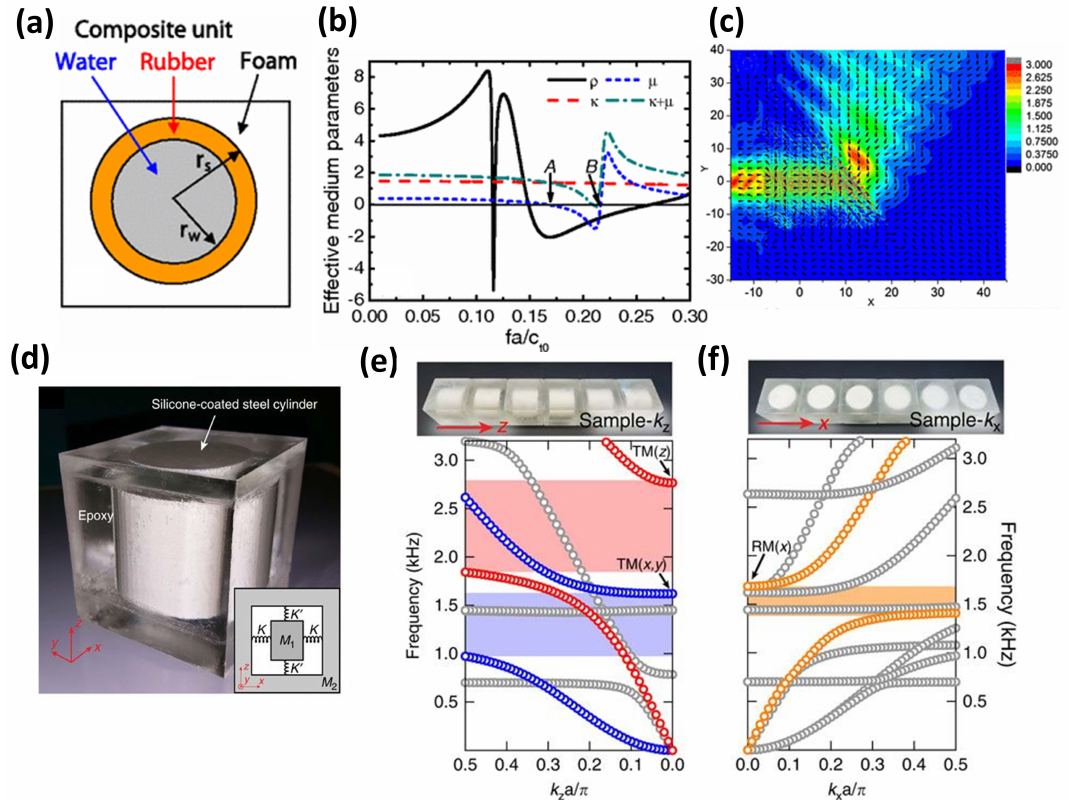
Figure 1. ( a ) Unit cell of the locally resonant elastic metamaterial (EMTM); ( b ) Effective medium parameters of proposed EMTM. Black line: mass density, ρ . Blue line: shear modulus, µ . Red line: bulk modulus, κ . Green line: κ + µ ; ( c ) Total flux distribution for a transverse wave incidence on the wedge. Colors: the magnitude. Black Arrows: directions; ( d ) Unit cell design of a locally resonant EMTM; ( e ) The band structure of z-axis alligned EMTM. Blue shaded region: a flexural bandgap. Red shaded region: a longitudinal bandgap; ( f ) The band structure of x-axis alliged EMTM. Orange shaded region: a torsional bandgap. ( a – c ) adapted from [56]. ( d – f ) adapted from